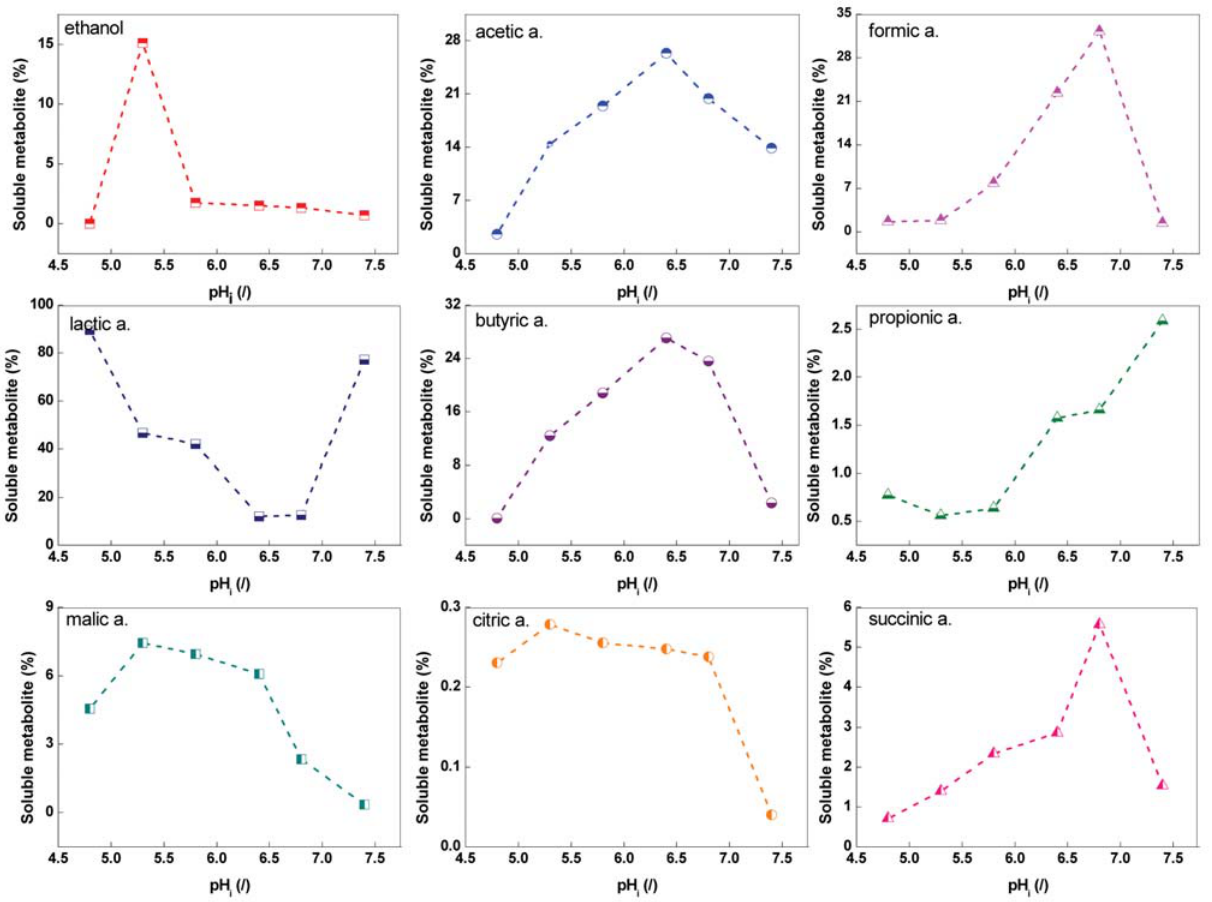
Figure 3. Soluble metabolites distribution (%) on the end of exponential phase for different initial pH values of fermentation broth. Lines show